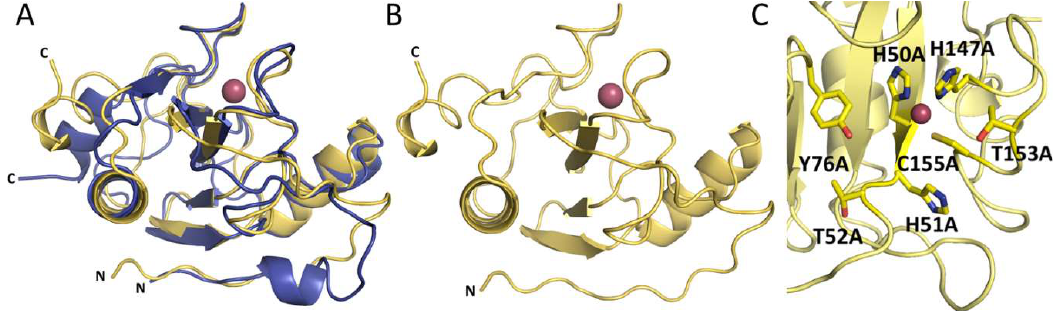
Figure 6. ( A ) Superposition of LysC (yellow) and Ph2119 endolysin (blue) structures. Except for the flexible N -terminal ( N ) and C -terminal ( C ) regions, the overall structures, including the Zn 2+ sites, are conserved. ( B ) LysC with Zn 2+ (pink sphere). ( C ) The 7 amino acids (sticks representation) around the Zn 2+ site, which were substituted by alanine.